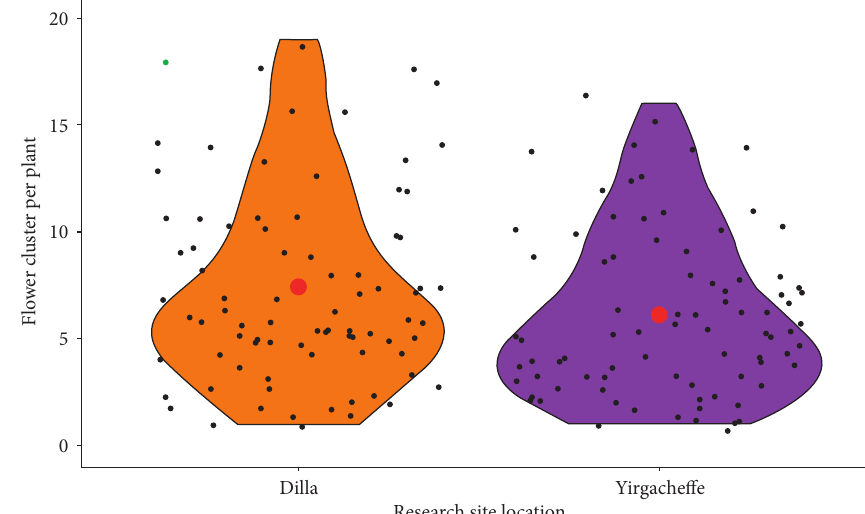
Figure 11: Grapevine flower cluster number in different research site